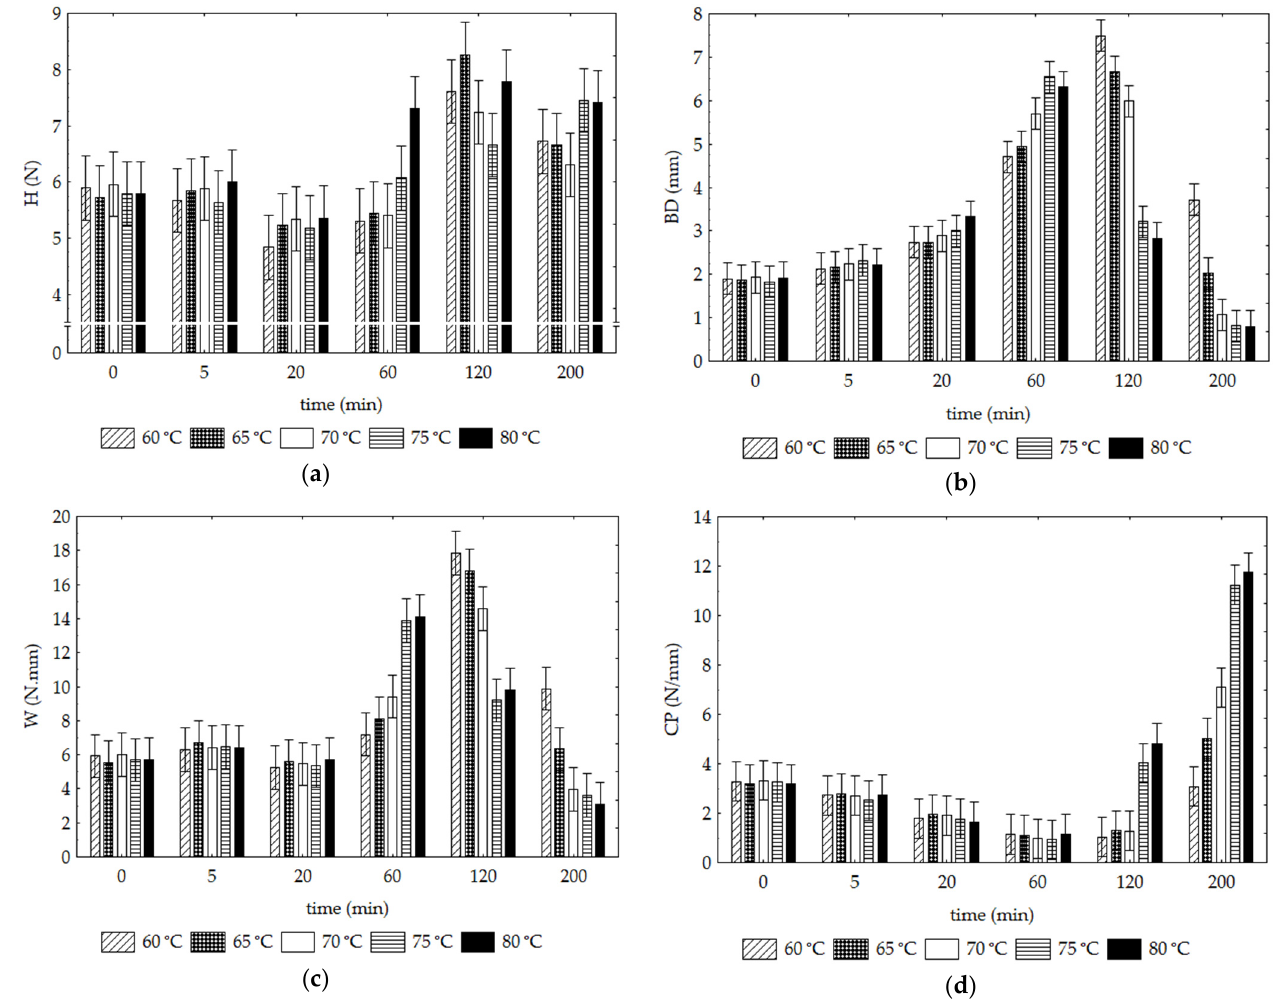
Figure 4. Sweet potato texture parameters change as a function of temperature and time of drying: ( a ) hardness (H), ( b ) breaking distance (BD), ( c ) work of fracture (W) and ( d ) crispness (CP). Vertical bars denote 0.95 confidence intervals.